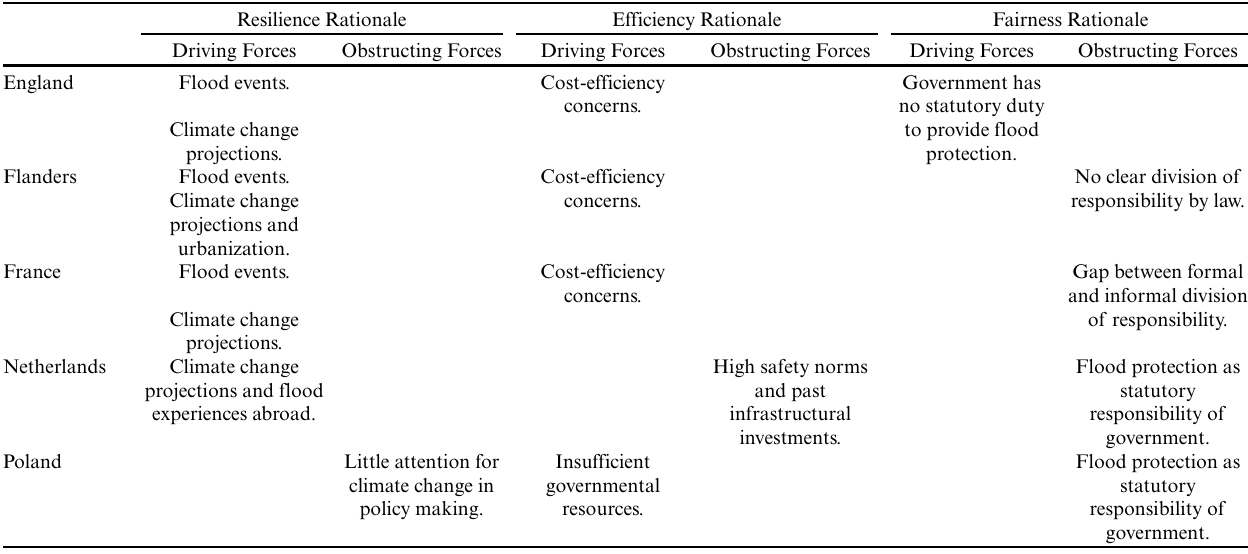
Table 3 . Overview of governmental rationales behind coproduction and their driving and obstructing